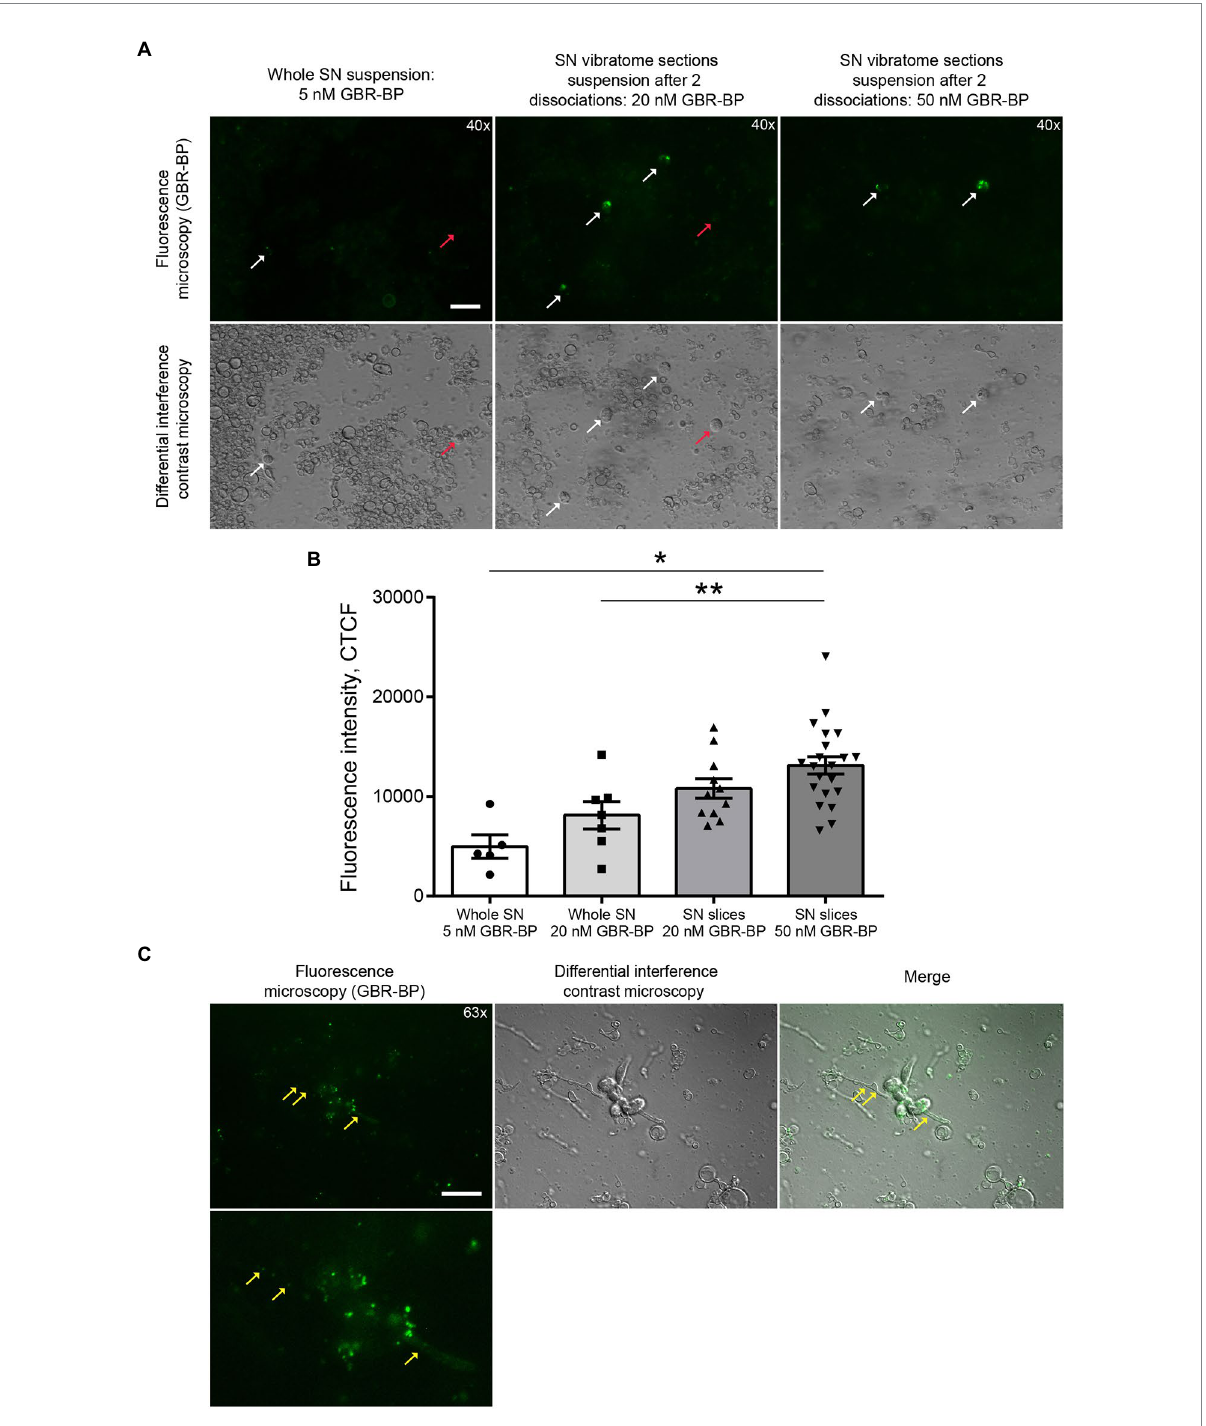
FIGURE 3 GBR-BP staining of dopaminergic neurons in the substantia nigra (SN). (A) Fluorescence microscopy and differential interference contrast microscopy of SN cell suspensions stained with GBR-BP. White arrows, GBR-BP-stained cells; red arrows, GBR-BP-unstained cells. Scale bar, 20 μ m. (B) Comparison of fluorescence intensity of GBR-BP-stained cells in cell suspensions. (C) Internalization of GBR-BP in dopaminergic neuron cell bodies and processes after dissociation of SN vibratome section suspension stained by 20 nM GBR-BP. Yellow arrows, GBR-BP-stained cell processes. Scale bar, 20 μ m. Statistics indicate significance by one-way ANOVA. p values were corrected for multiple comparison (Tukey) (* p < 0.05 compared with the whole SN 5 nM GBR-BP group; ** p < 0.05 compared with the whole SN 20 nM GBR-BP group). Data are presented as mean ± SEM. n = 10 field of view for each